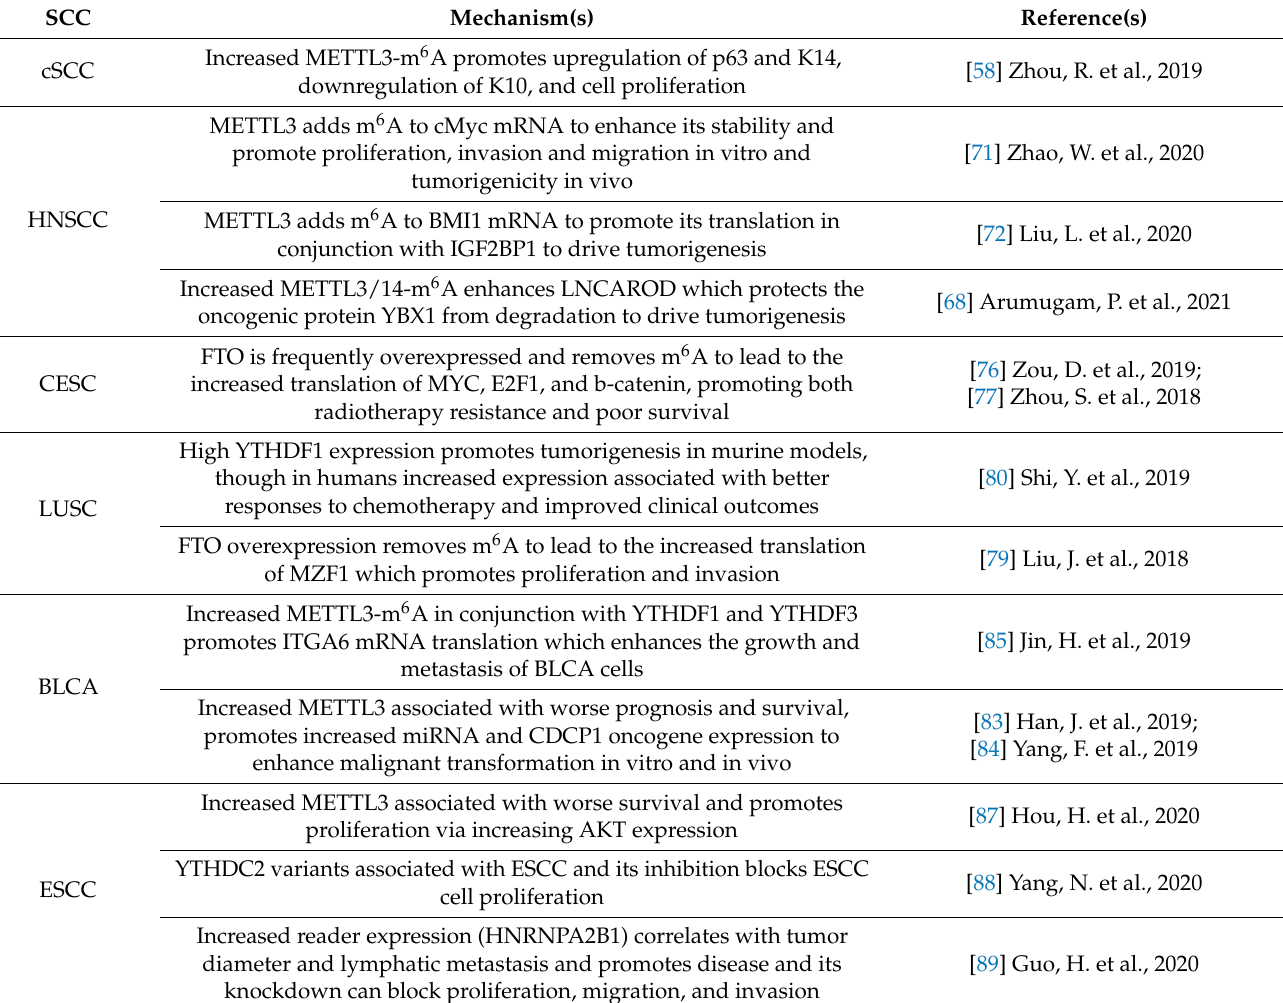
Table 1. Summary of mechanistic studies into the role of the METTL3-m 6 A epitranscriptome in epithelial cancers, and particular